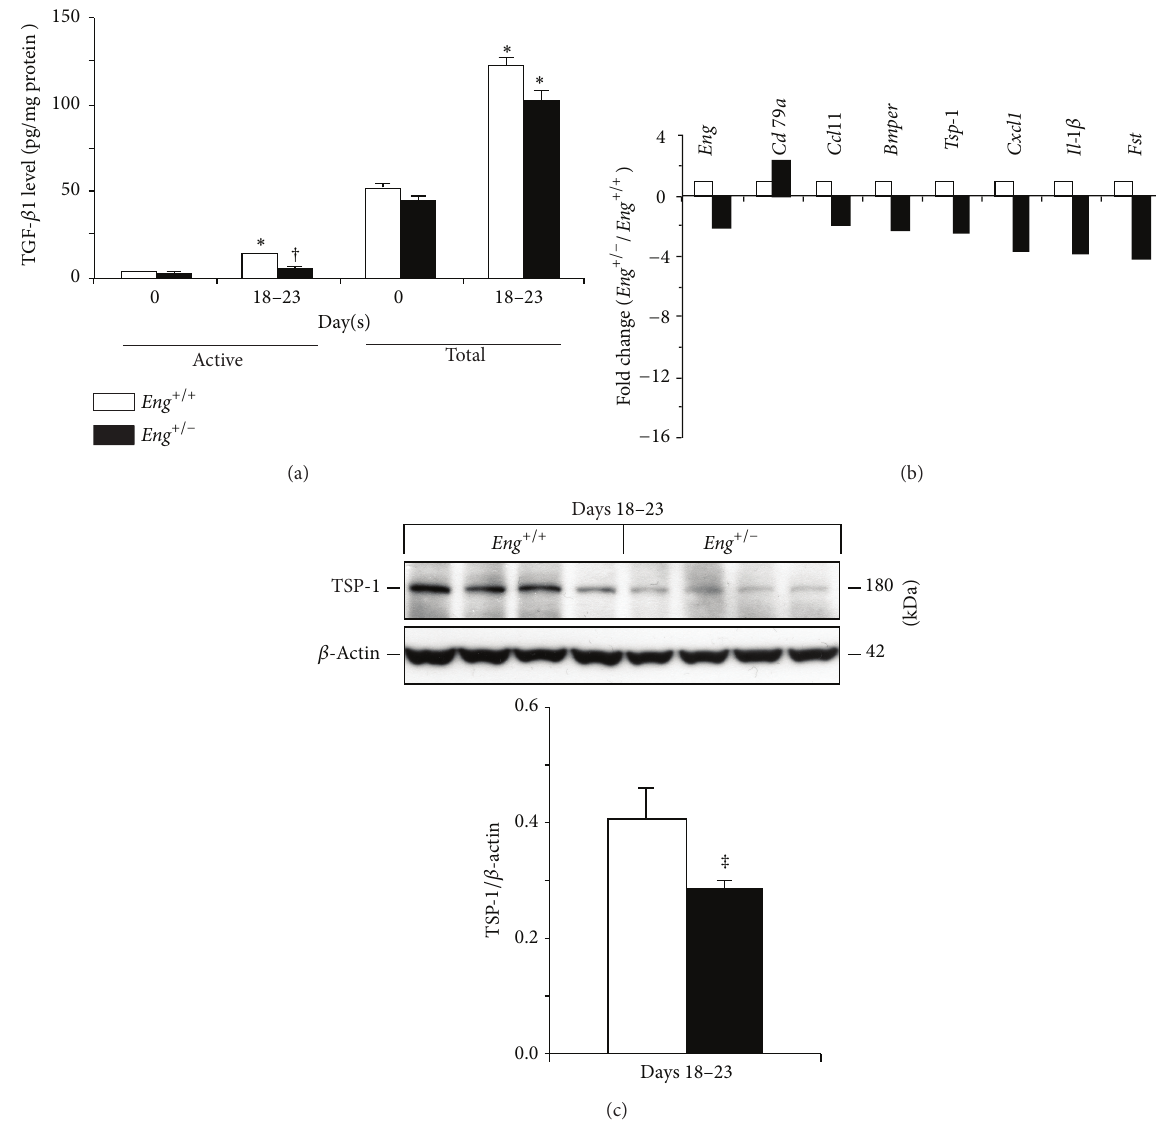
Figure 2: Reduced active TGF- 𝛽 1 levels and altered expression of factors that regulate angiogenesis and resolution in Eng +/− mice undergoing persistent inflammation. (a) Endogenously active (without acid treatment) and total (with acid treatment) TGF- 𝛽 1 levels were measured by ELISA in colonic tissue of Eng +/+ and Eng +/− mice at days 0 and 18–23 ( 𝑁 = 6 mice for day 0 and 9-10 mice for days 18–23). ∗ 𝑃 < 0.05 versus corresponding day 0, † 𝑃 < 0.05 versus corresponding Eng +/+ group. (b) The mRNA expression profile of several angiogenic and TGF- 𝛽 pathway-related genes was assessed in colons of Eng +/+ and Eng +/− mice during the resolution phase. The results are expressed as a fold- change ( Eng +/− over Eng +/+ mice) and only significantly ( 𝑃 ≤ 0.05 ) altered genes with a 2-fold or greater change are shown ( 𝑁 = 4 mice for Eng +/+ group and 5 for the Eng +/− group; BMP endothelial cell precursor-derived regulator ( Bmper ), follistatin ( Fst ), and thrombospondin- 1 ( Tsp-1 )). (c) Representative immunoblot and densitometric analysis of TSP-1 expression, normalized to 𝛽 -actin, in colons of Eng +/+ and Eng +/− mice at days 18–23 of colitis. TSP-1 levels were nondetectable at days 0 and 7–9 ( 𝑁 = 6 mice for Eng +/+ group and 5 for the Eng +/− group). ‡ 𝑃 = 0.072 versus Eng +/+ mice. Results represent mean ±